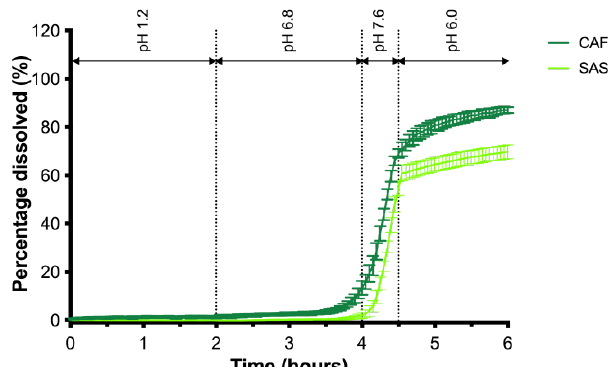
Figure 4. Release of SAS and CAF release in GISS I-IV from ColoPulse coated MCC_CCS_EtOH pellets (mean ± SD, n =